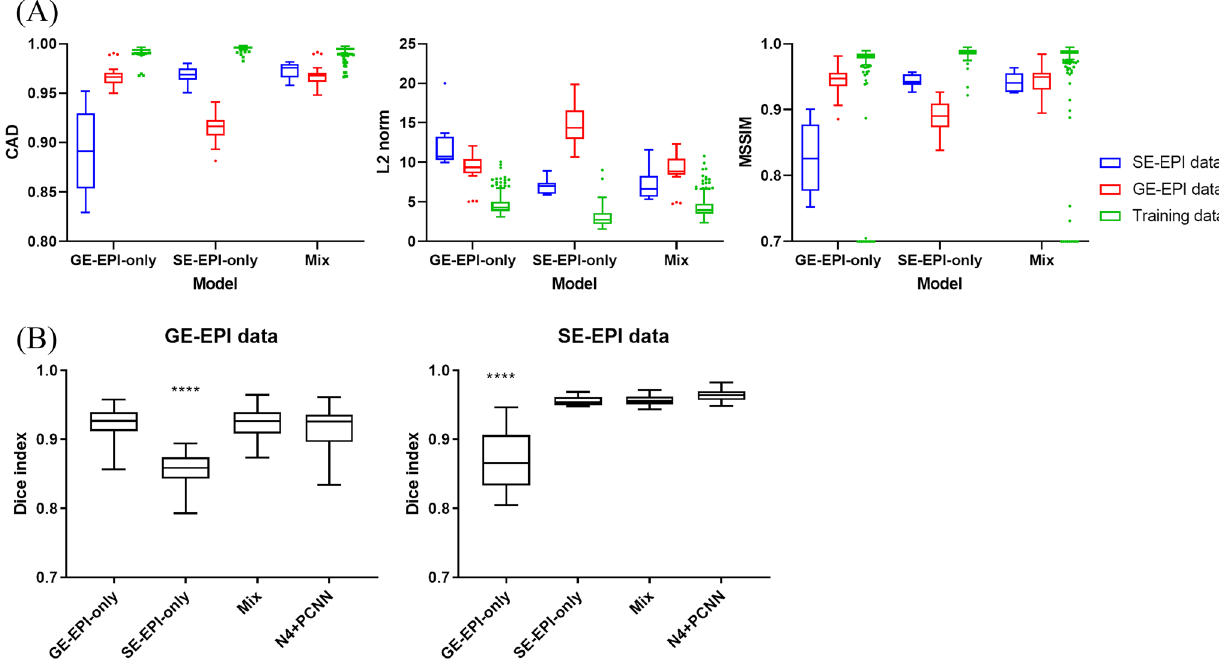
Figure 4. Performance comparison using mixed testing data. Box plots of ( A ) CAD, L2 norm and MSSIM, and ( B ) Dice index. ****p <